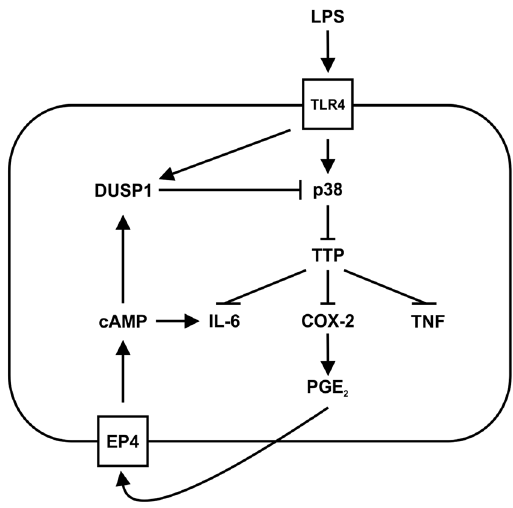
Figure 7. Schematic representation of the feedback control of macrophages by PGE 2 , DUSP1 and TTP. Note that the effects of PGE 2 -mediated feedback are delayed because of the gradual accumulation of PGE 2 , and therefore operate in a paracrine rather than autocrine fashion. The figure ilustrates possible regulatory connections, and is not intended to capture all the temporal complexities of feedback